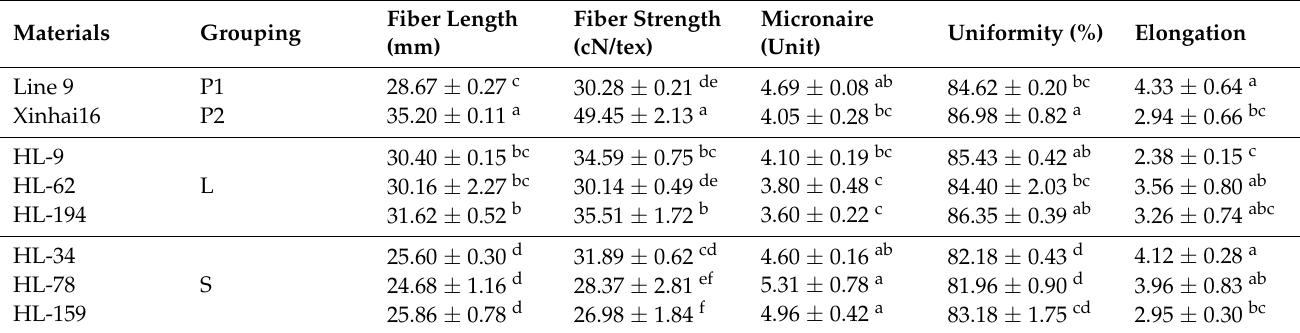
Table 1. Parental and extreme offspring fiber quality trait